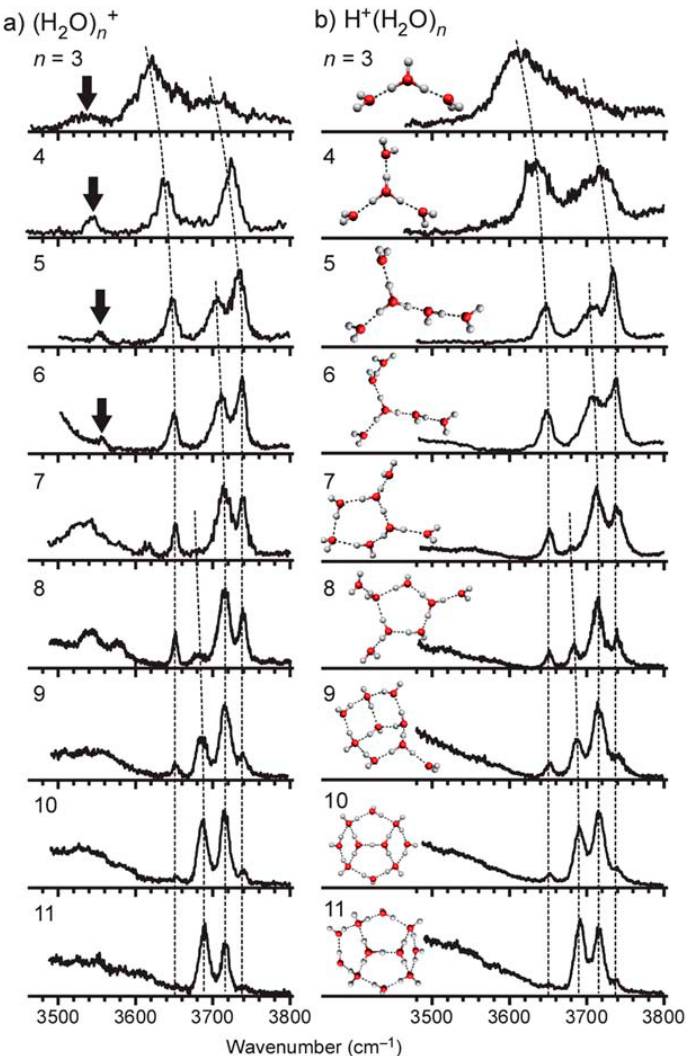
Figure 28. ( a ) IR spectra of (H 2 O) n+• (n = 3–11) in the free OH stretch region. ( b ) IR spectra and